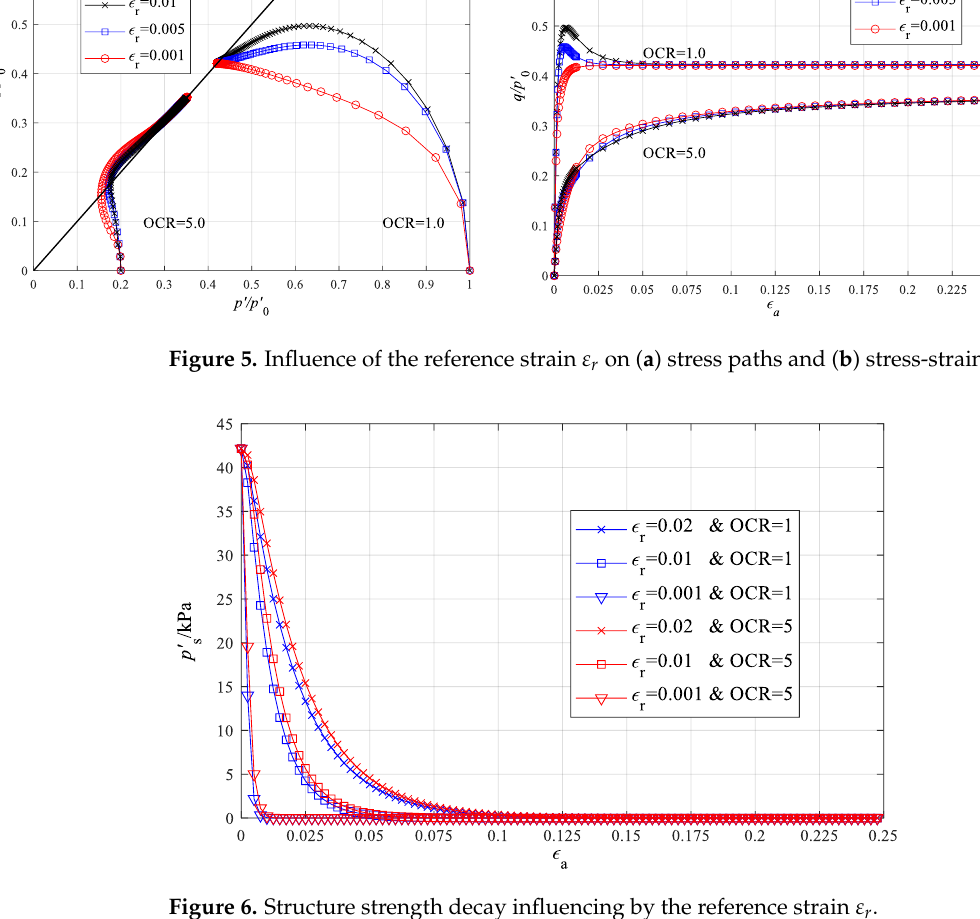
Figure 6. Structure strength decay influencing by the reference strain ε r . (c) Influence of spacing ratio r .